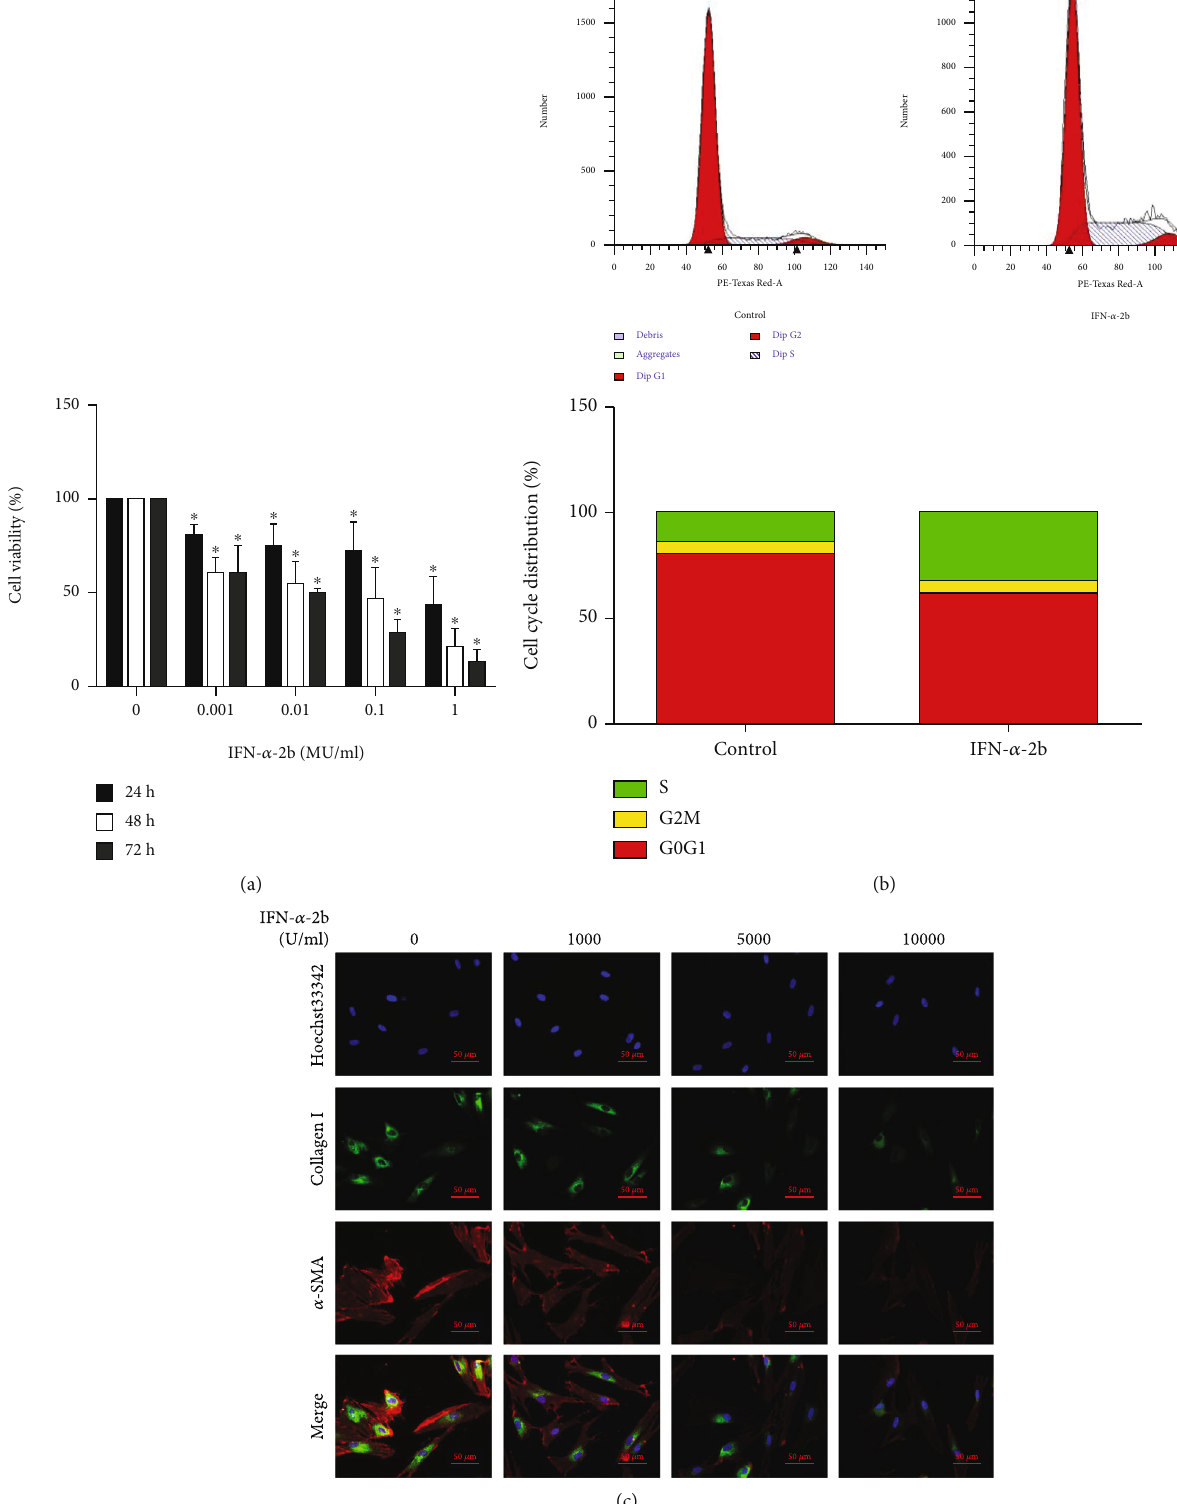
Figure 4: IFN- α -2b inhibited fi broblast proliferation and extracellular matrix secretion. (a) CCK-8 assay showed that IFN- α -2b inhibited fi broblast activity in a concentration- and time-dependent manner. (b) Flow cytometry analysis of cell cycle distribution showed that fi broblasts were arrested in the S phase after 48 hours of IFN- α -2b treatment. (c) The expression images of α -SMA and collagen I in cells treated with IFN- α -2b for 48 hours were observed under fl uorescence